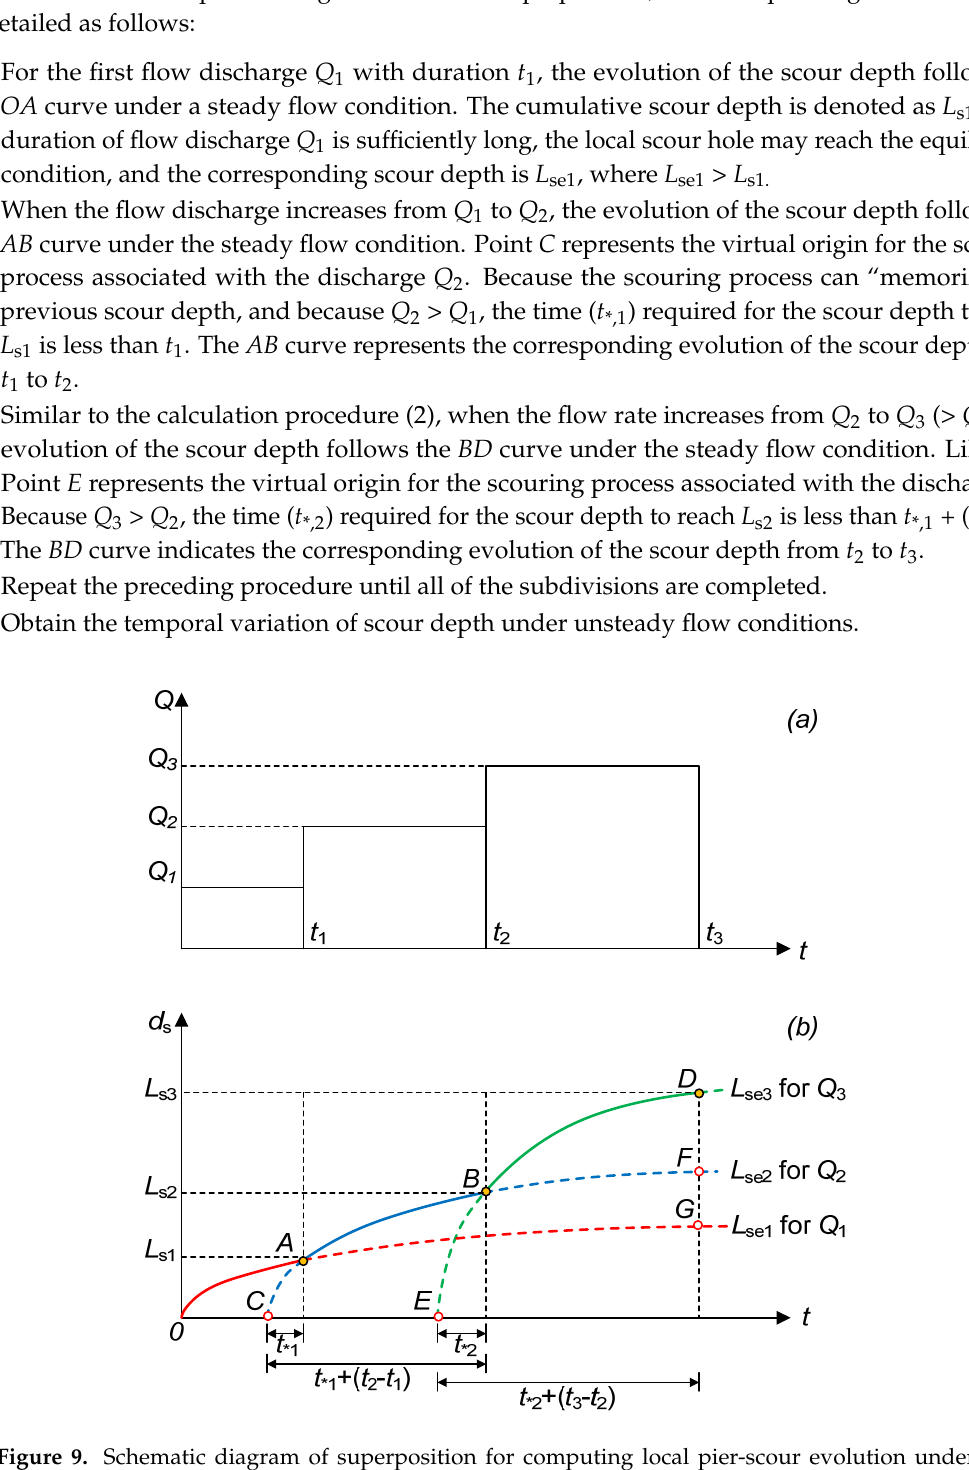
Figure 9. Schematic diagram of superposition for computing local pier-scour evolution under a stepwise hydrograph: ( a ) stepwise hydrograph; ( b ) evolution of scour depth.